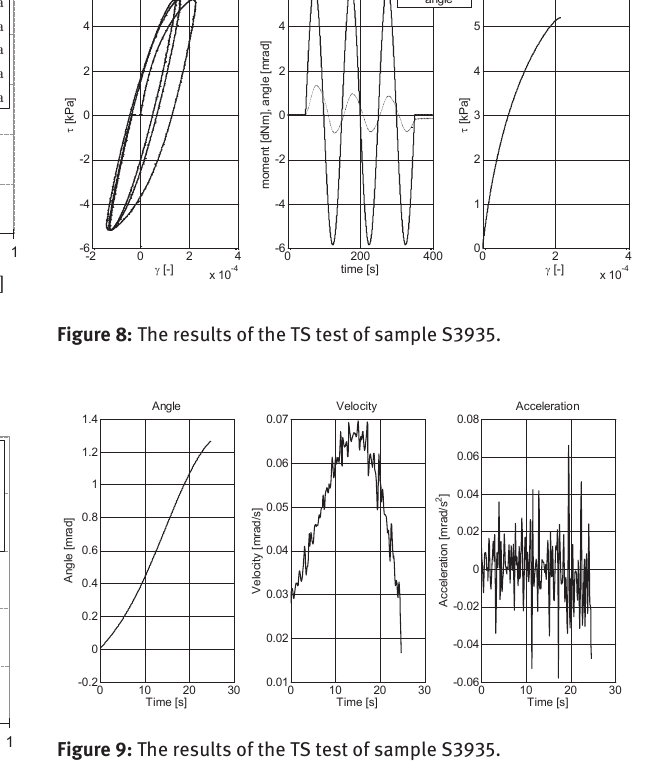
Komentarz [Q29]: TS: Please change X-axis and Y-axis labels to sentence case in all figures. Komentarz [R30]: Done.